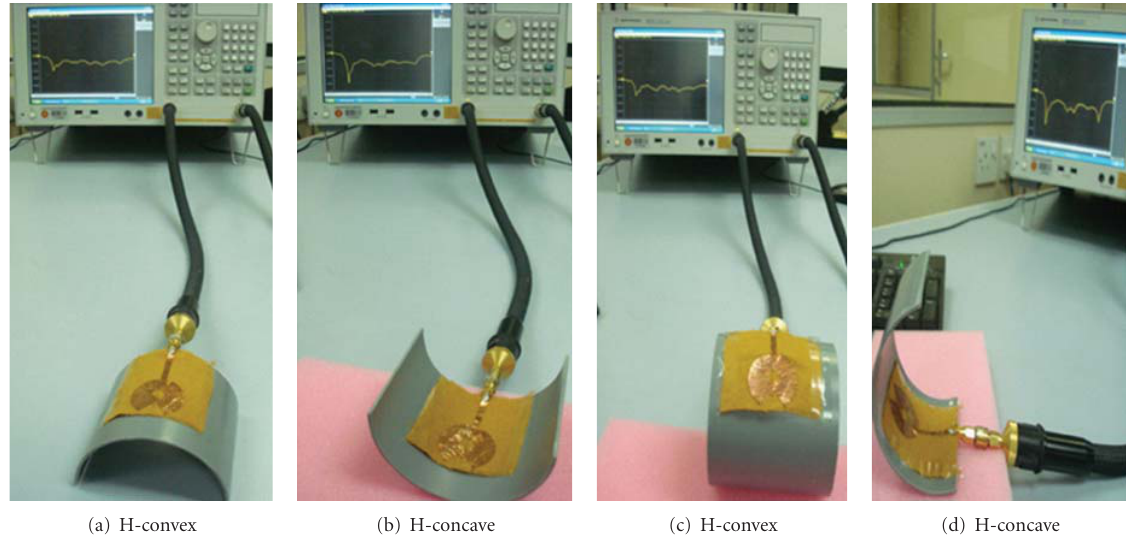
Figure 8: Snapshots of measurement environment of UWB antenna prototype using copper conducting sheet.